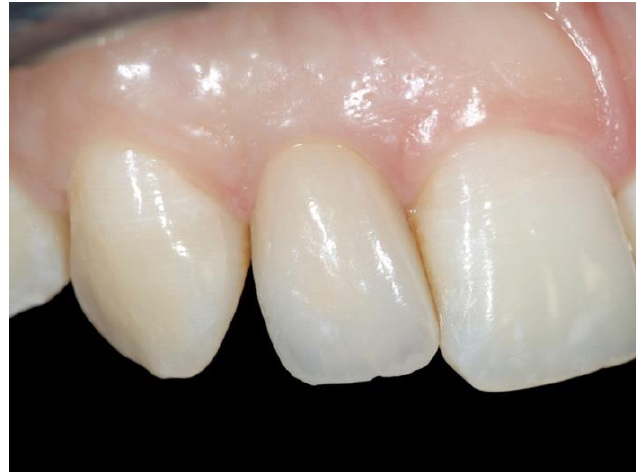
Figure 4. Post-operative view 3 weeks after the cementation of the implant-supported AGC onto the titanium abutment in position 12.